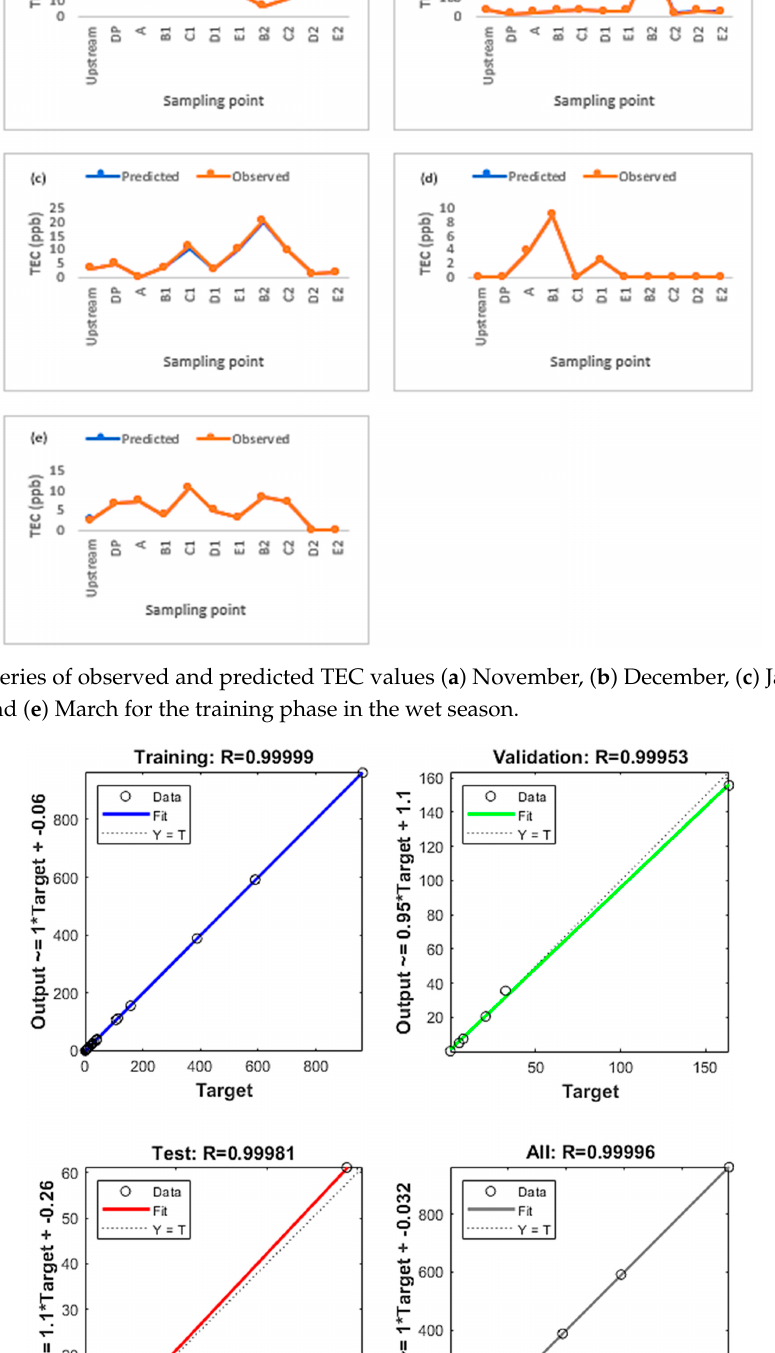
Figure 14. Comparison of the predicted and observed TEC values for training, validation, and testing phases in the wet season.